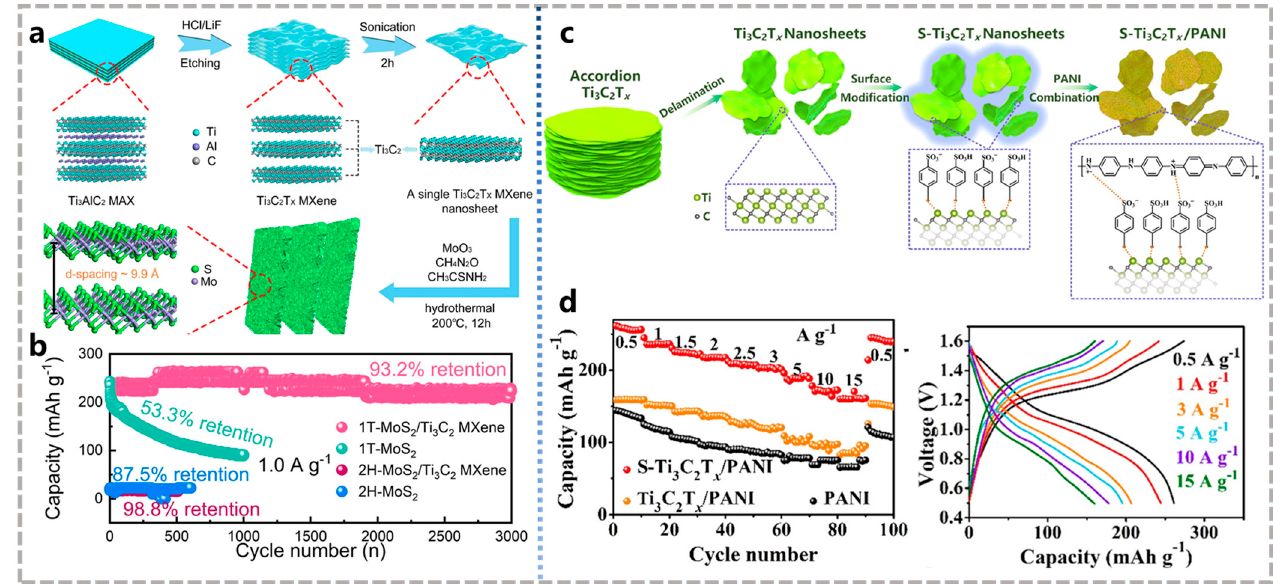
Figure 11. ( a ) Synthesis schematic of 1 T-MoS 2 /Ti 3 C 2 MXene. ( b ) Cycle performance at 1.00 A g − 1 of 1 T-MoS 2 /Ti 3 C 2 MXene and 1 T-MoS 2 [167]. ( a , b ) Reproduced with permission from ELSEVIER